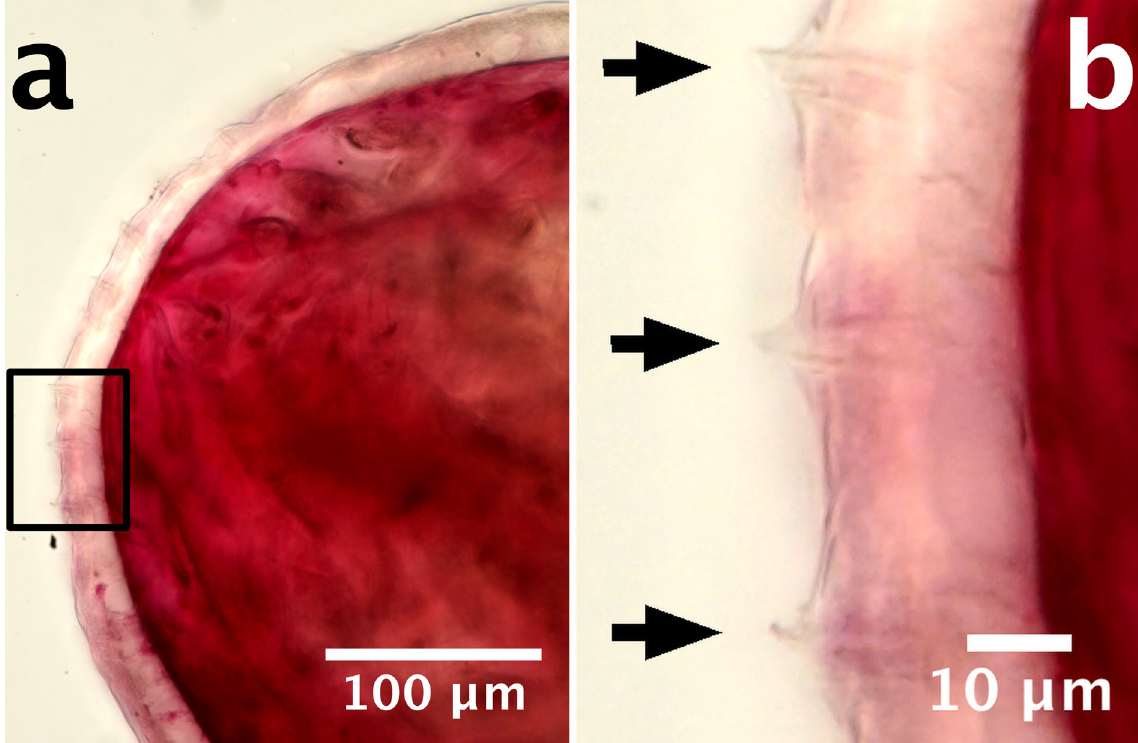
Fig. 8. LM micrographs of genital spines of a ♀ Corynosoma strumosum (HWML 39481–1158-2) from a grey seal, Halichoerus grypus, from the archipelago of Åland (Finland). a . Posterior of trunk. b . Enlargement of rectangular region in subfigure